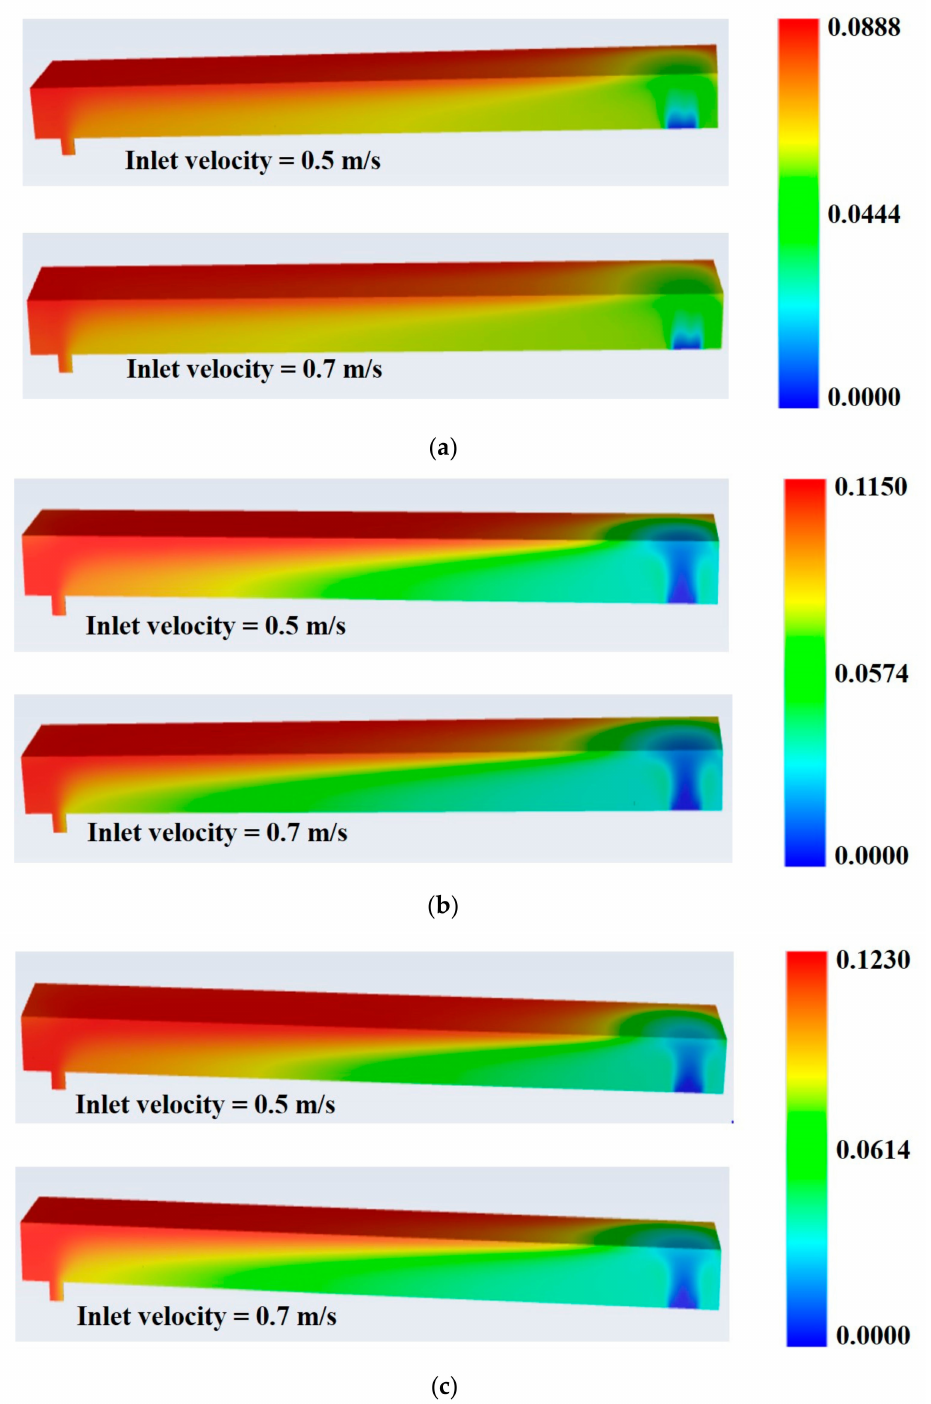
Figure 6. Contours of CO 2 mass fraction: ( a ) case I; ( b ) case II; and ( c ) case III at di ff erent inlet